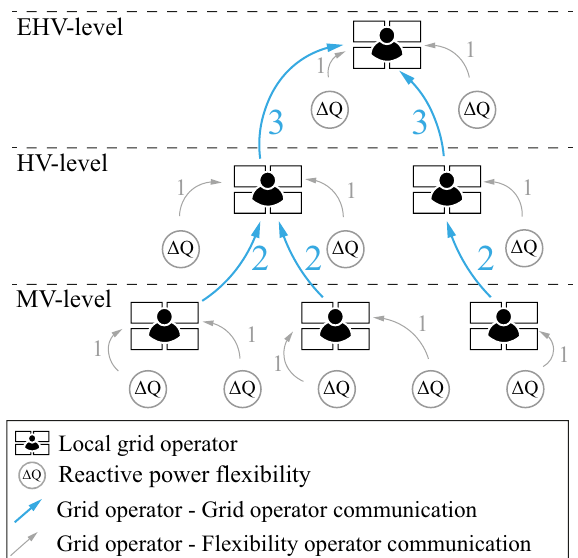
Fig. 1 Phase 1: Determination of EPFs for each grid operator by bottom-up principle (Numbered arrows indicate the chronological order of the communication